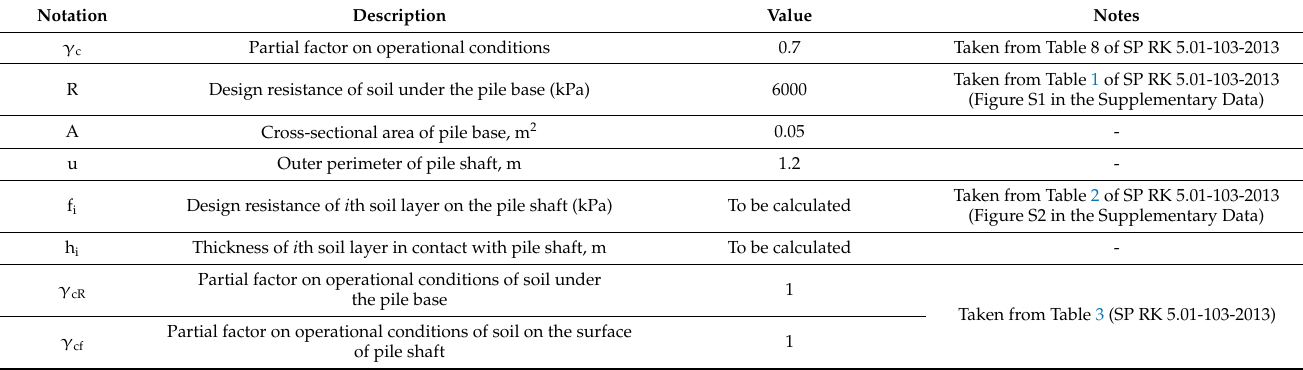
Table 2. Description of parameters in SP RK 5.01-103-2013—Pile